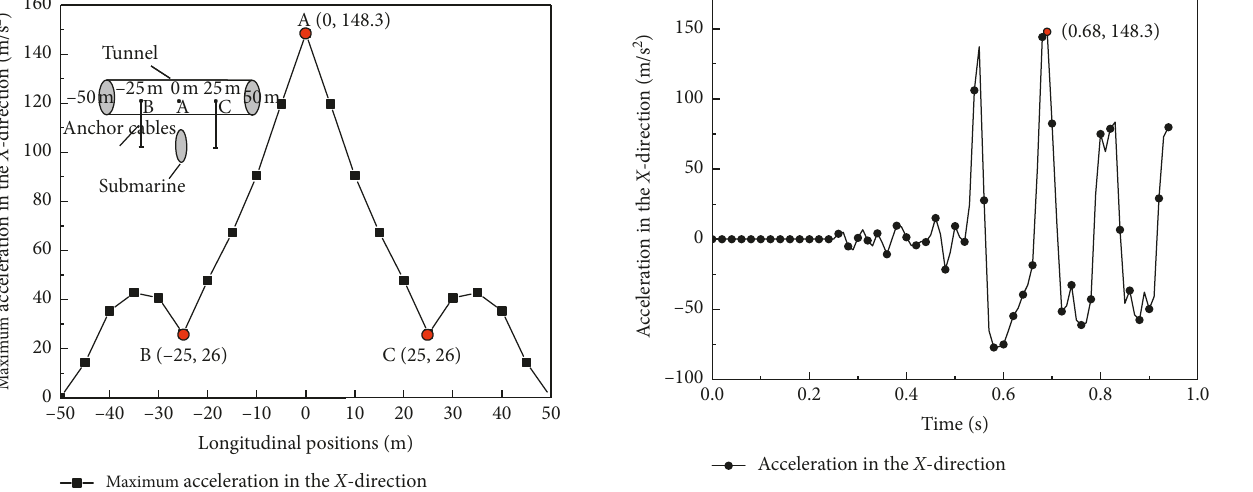
Figure 14: Maximum X -direction acceleration at different longi- tudinal positions.